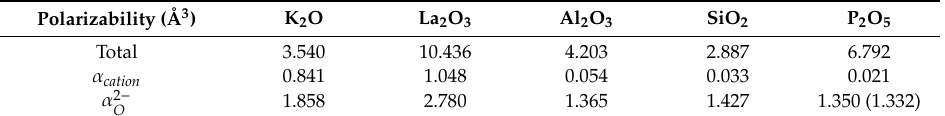
Table 2. Polarizabilities of the di ff erent single oxides constituting the samples of Table 1. The cation and anion contributions are also indicated. The data, except for Yb 2 O 3 , where taken from Refs. [26–29]. The value indicated in parenthesis for P 2 O 5 (bolded) has been calculated as indicated in the text. K 2